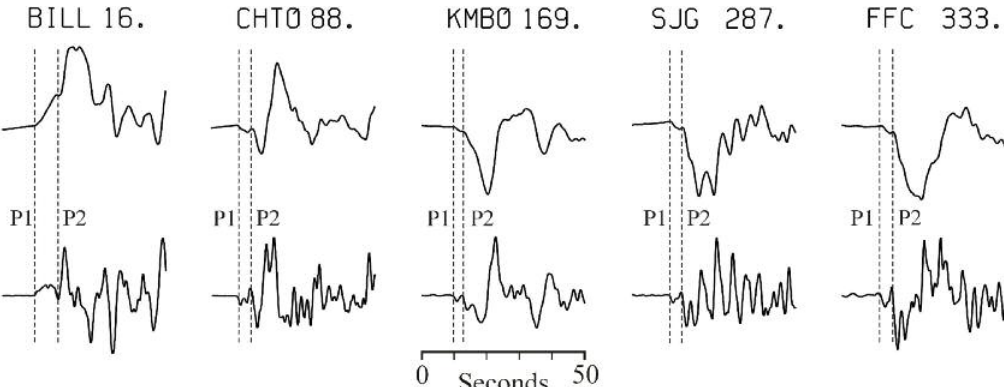
! Figure 12. Far-field broadband displacement (top) and velocity (bottom) recordings for the 1999 İ zmit earthquake from several stations. The records are bandpass filtered with corner frequencies at 0.01 Hz to 1.0 Hz. A precursory source feature that appears as a small shoulder before the main P displacement pulse and as a tiny pulse before the major P velocity pulses is clearly visible. The numbers on the right of the station names indicate azimuths, clockwise from the North. Vertical broken line labelled as P1 and P2, the first and the major P -wave energy arrivals at each station,